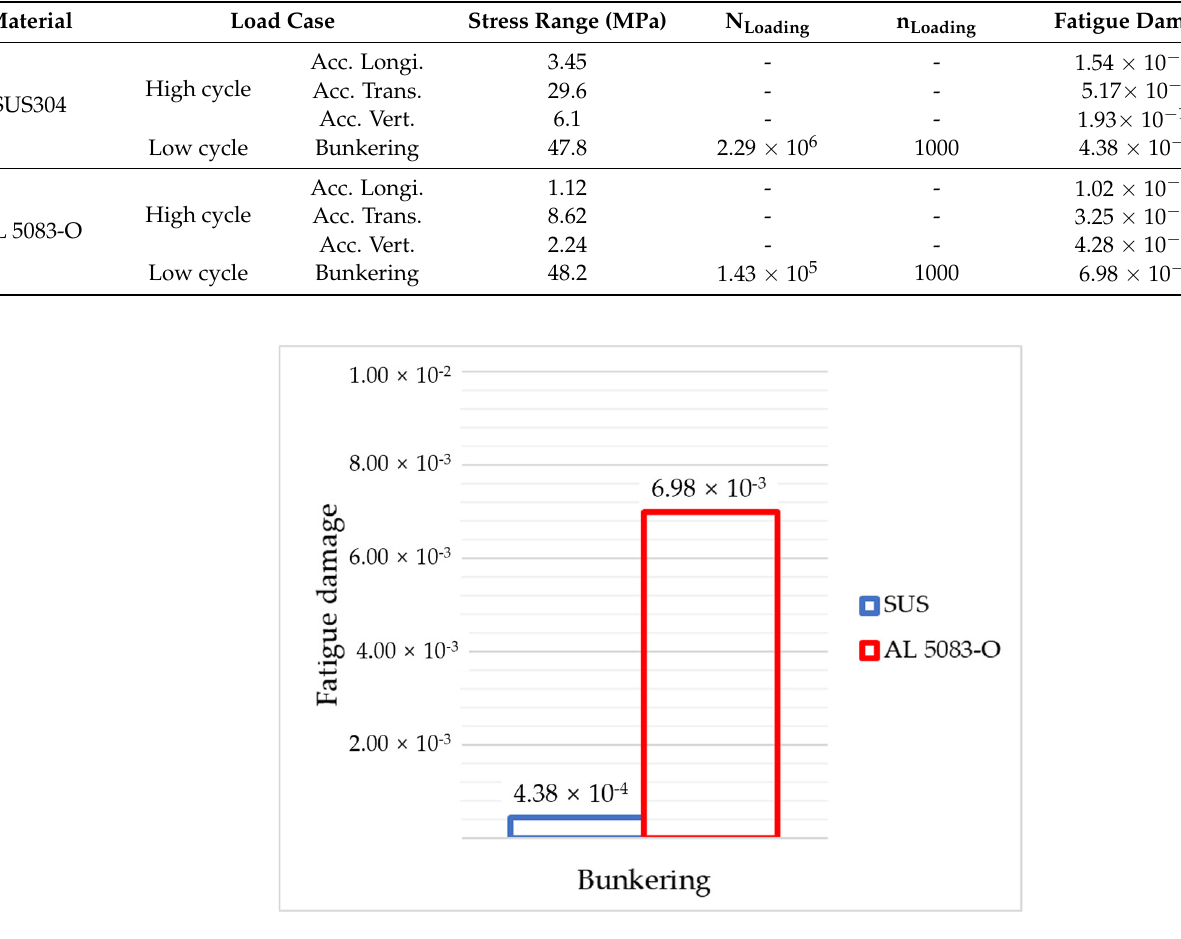
Figure 20. Comparison of low fatigue damage ratios based on different materials.